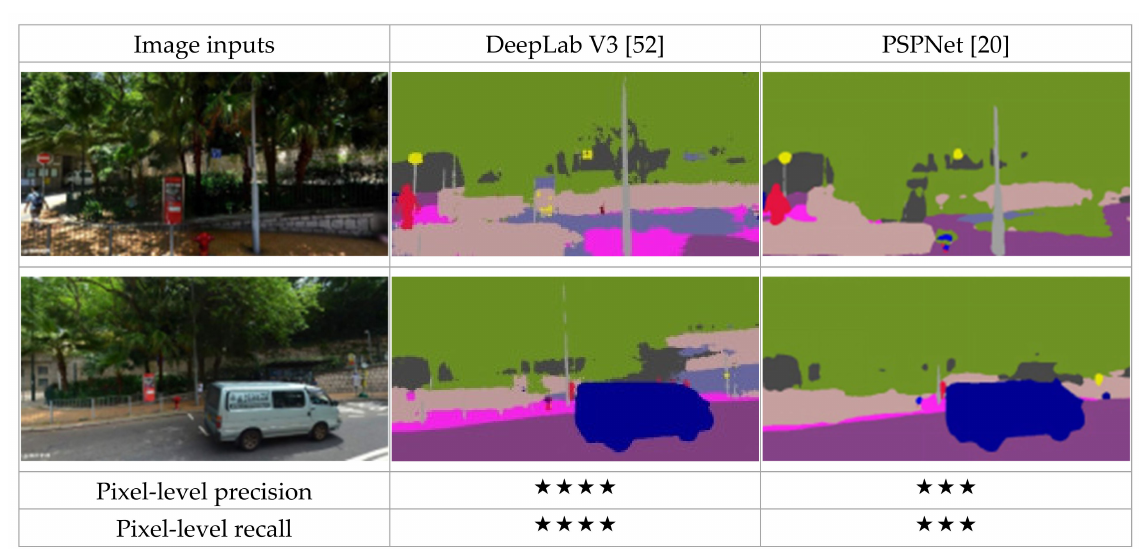
Figure 1. Illustrations of semantic segmentation by transferring two trained popular CNN models, where color indicates the class labels as defined in Cordts et al. [53] 2006.